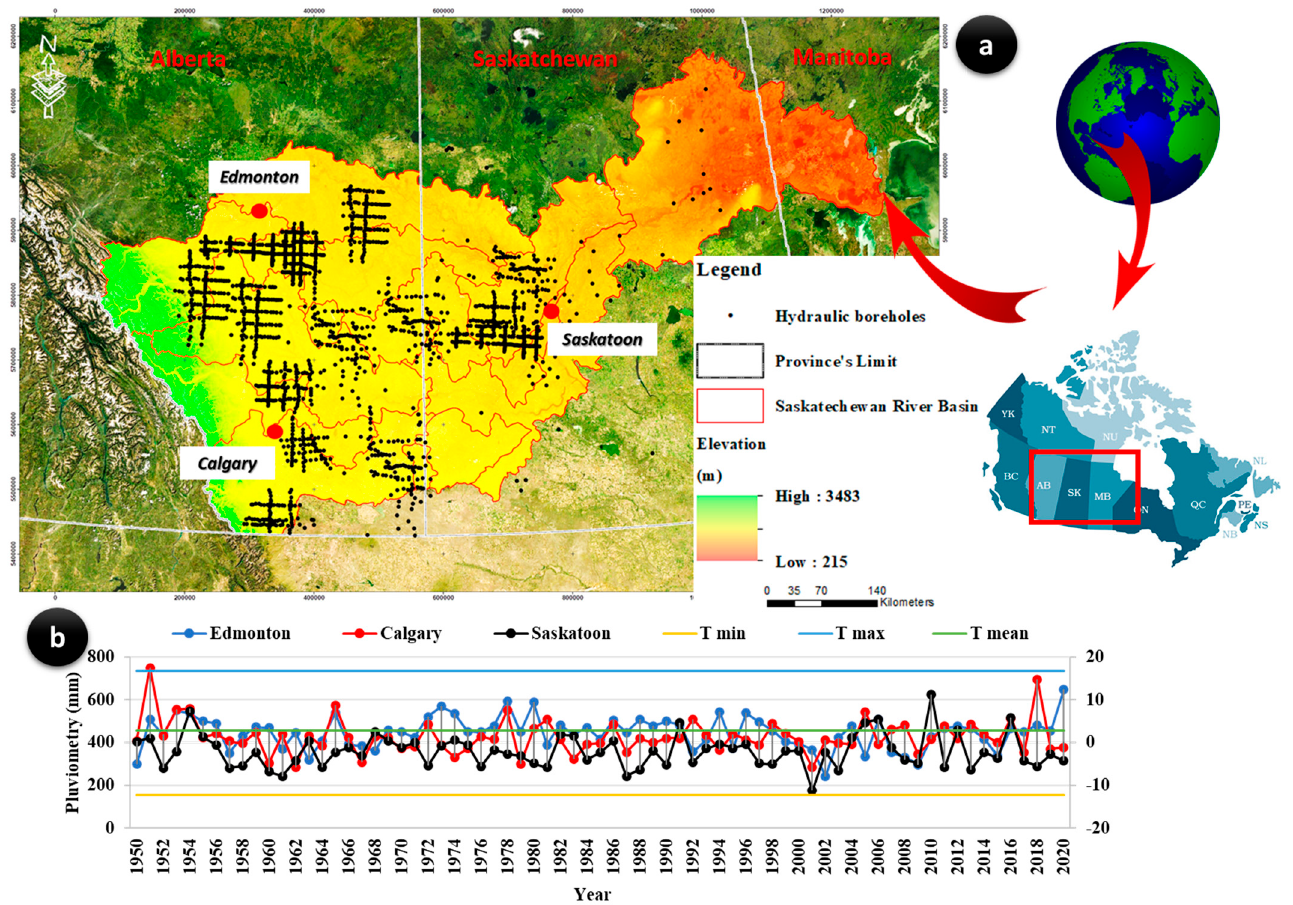
Figure 1. ( a ) Geographic localization of the Saskatchewan River Basin (SRB) and sample hydraulic boreholes. ( b ) Climatological characteristics of the SRB: mean between 1950 and 2020 (Government of Canada, Weather, Climate, and Hazard: past weather and climate, 2021).